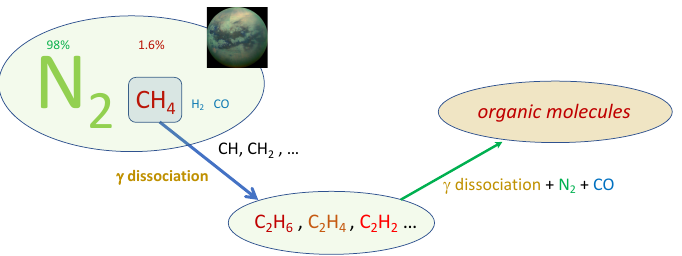
Figure 2. Prebiotic chemistry in Titan